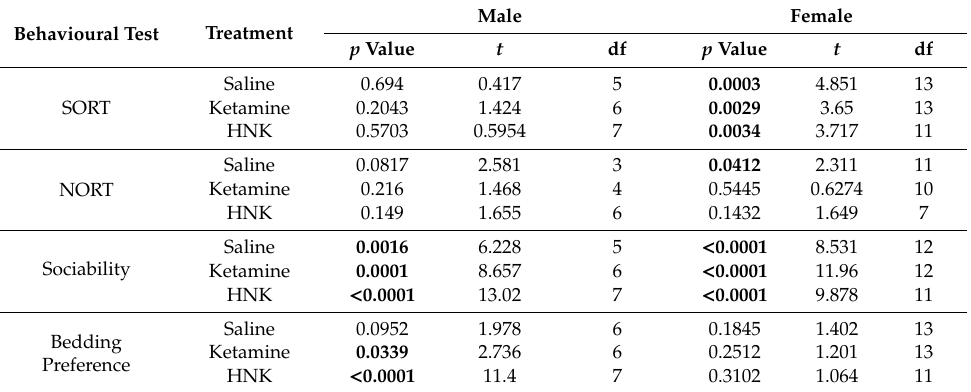
Table 2. Statistical analysis of the performance in the behavioral battery compared to chance level (one sample t -test). t = t score, df = degrees of freedom. Bold p values represent significant values, indicating di ff erence compared to 50% chance